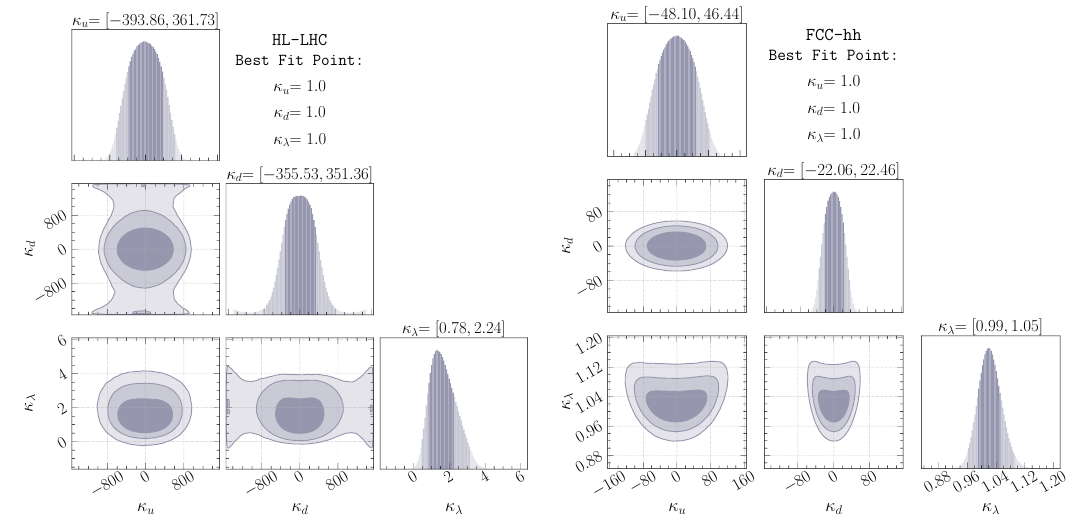
Figure 7 . Three parameter fits with C uφ , C dφ and C φ , 6 ab − 1 of luminosity at 14 TeV for HL-LHC (left panel) and 30 ab − 1 of luminosity at 100 TeV for FCC-hh (right panel). The one-dimensional distributions are derived from the two-dimensional distributions by marginalization using uniformly distributed priors for the independent variables with ranges sufficiently large to accommodate much more than 5 σ variation of the variables from their central